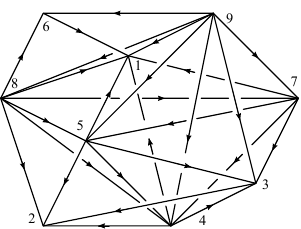
Figure 1. A portion of a graph that represent the basis vectors in the Hilbert space. Each edge carries an arrow and is assigned a group element denoted by [ ab ] with a < b